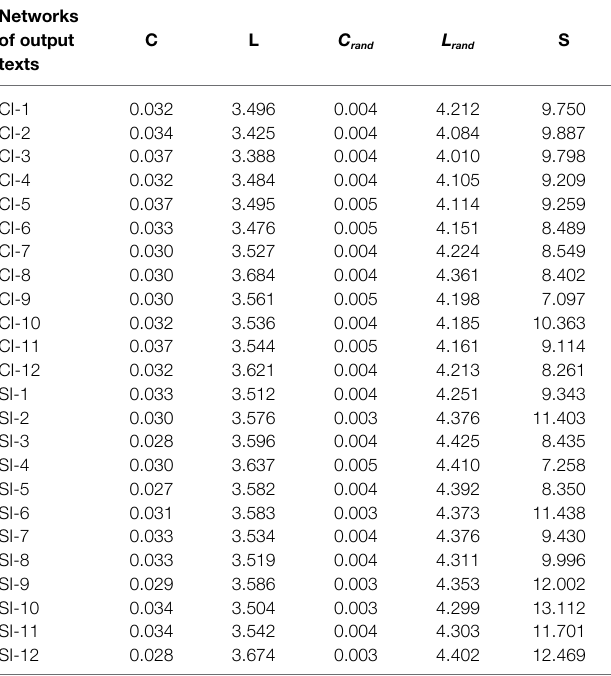
TABLE 4 | Results of key parameters measuring network small-worldness (networks of output texts). Networks of output